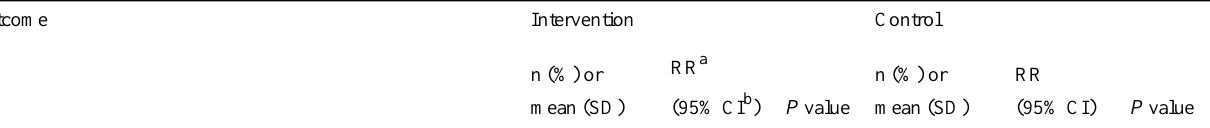
DUMMY TABLE - CELLS INTENTIONALLY EMPTY Primary